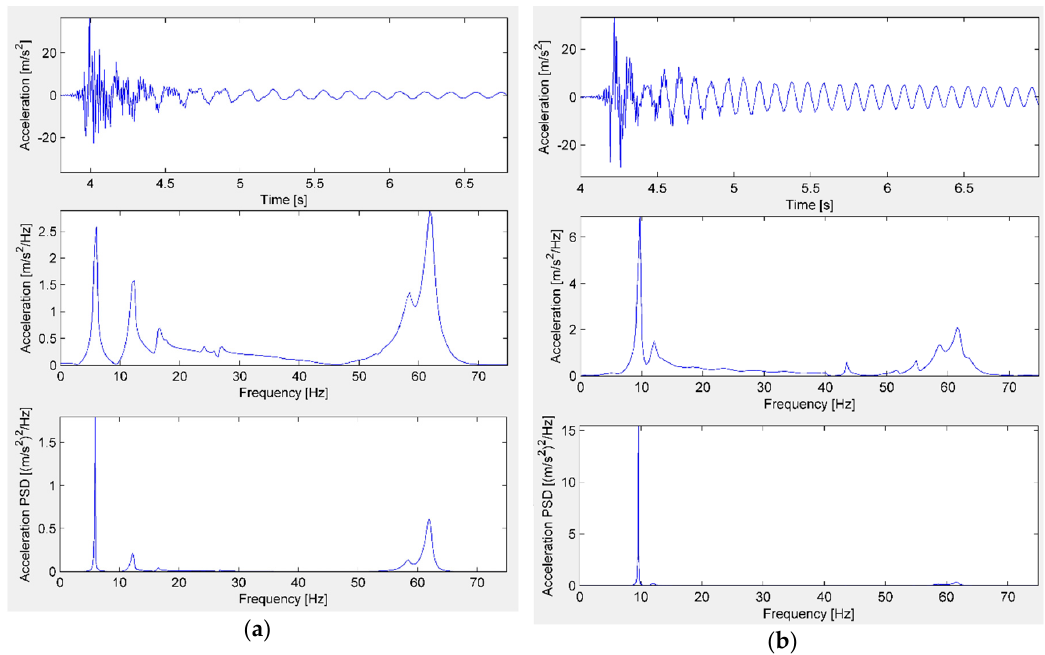
Figure 7. The acceleration in time domain, the acceleration in frequency domain, the power spectral density (PSD) of the acceleration in frequency domain of the signal 4x induced by the azimuth 240 degree impulse strike for: ( a ) the prestress level 4; ( b ) the prestress level 13.